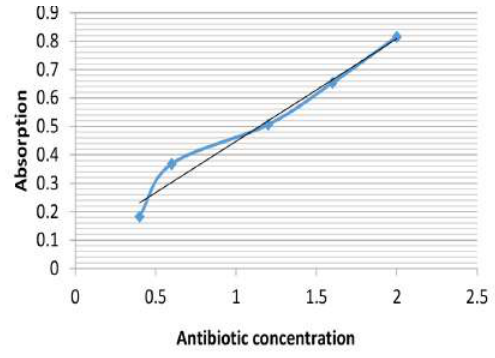
Fig. 3. Calibration curve of cefazolin